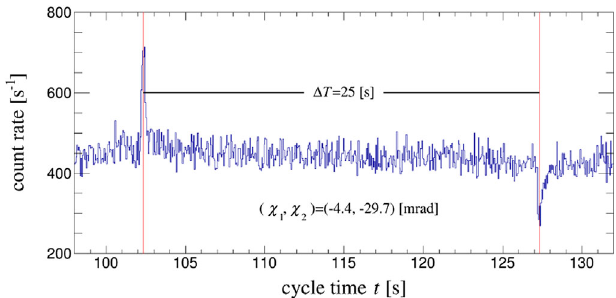
FIG. 6. Spikes of the count rate in the polarimeter at the beginning of the time interval Δ T 2 when the two solenoids S 1 and S 2 are switched ON (producing the indicated rotation angles χ 1 and χ 2 ) at t ≈ 103 s and at the end at t ≈ 127 s when S 1 and S 2 are turned